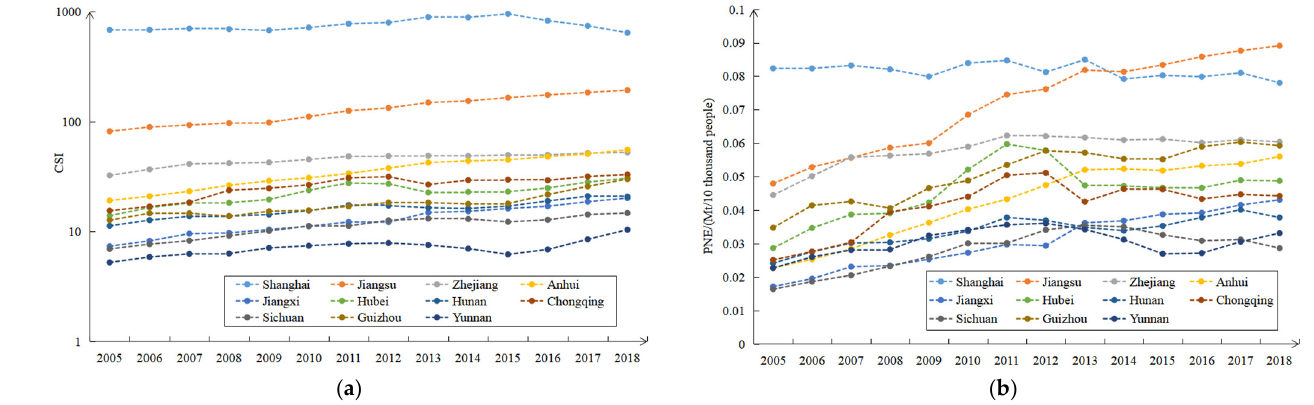
Figure 2. ( a ) CSI value of 11 provinces and cities in the YREB from 2005 to 2018; ( b ) PNE values of 11 provinces and cities in the YREB from 2005 to 2018 [source: own illustration].